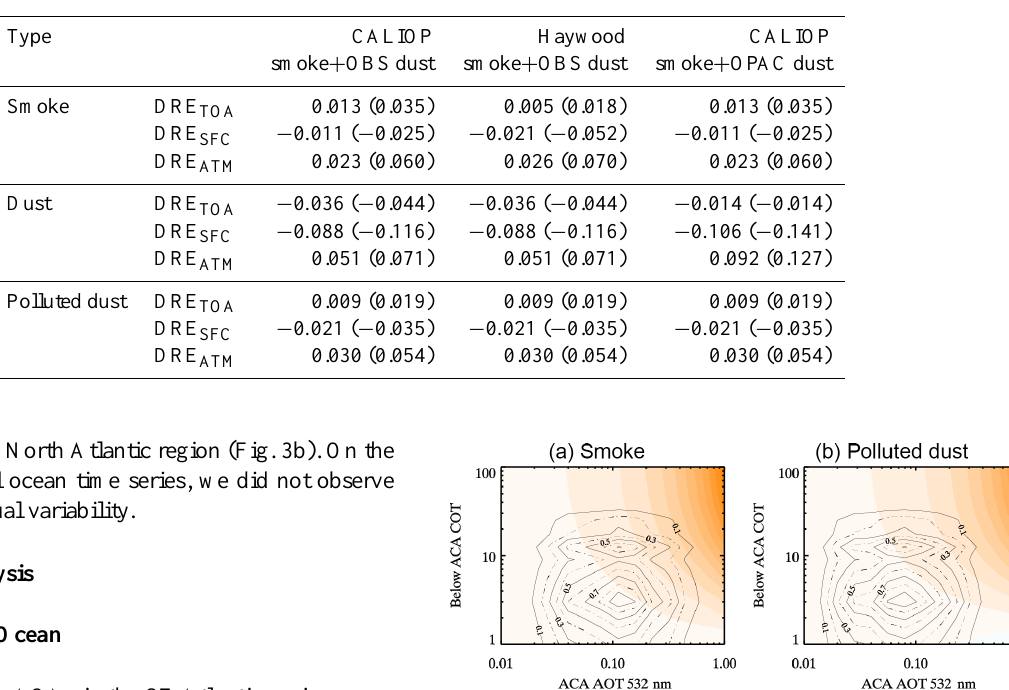
Table 3. The global annual mean of diurnally averaged cloudy-sky DREs at TOA induced by different types of ACA according to CALIOP observations. The numbers in the parentheses are results based on the scaled AOT (see Sect. 6 for details). The unit isWm − 2 .